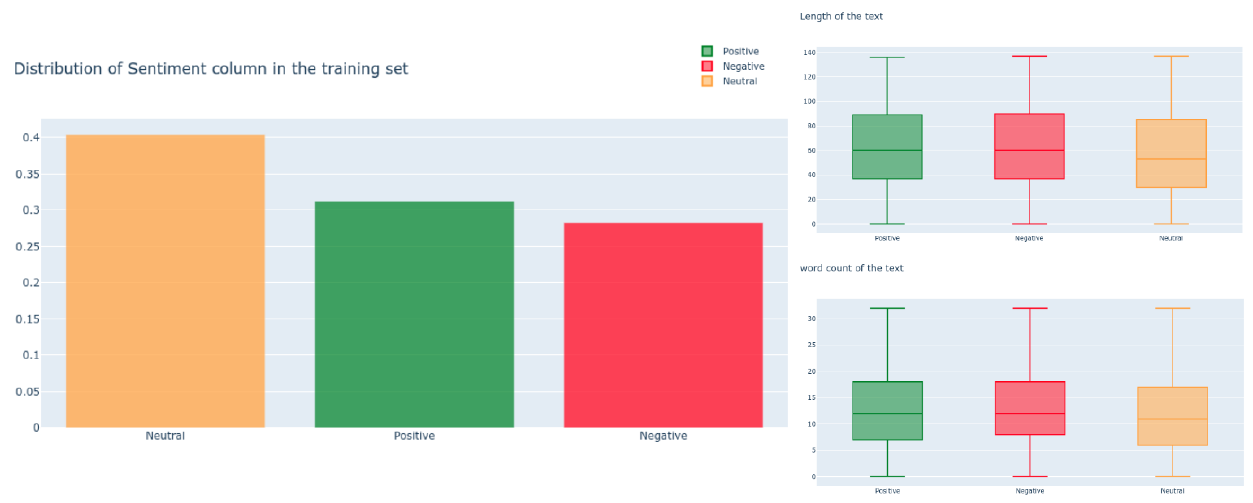
Figure 7. The left illustrates sentiment distributions, and the right is length of text and word count for each sentiment. Other statistics that we can extract from the corpus are N-grams, which are a con- tiguous sequence of N words/tokens/items from a given sample of text, as illustrated in Figure 8.